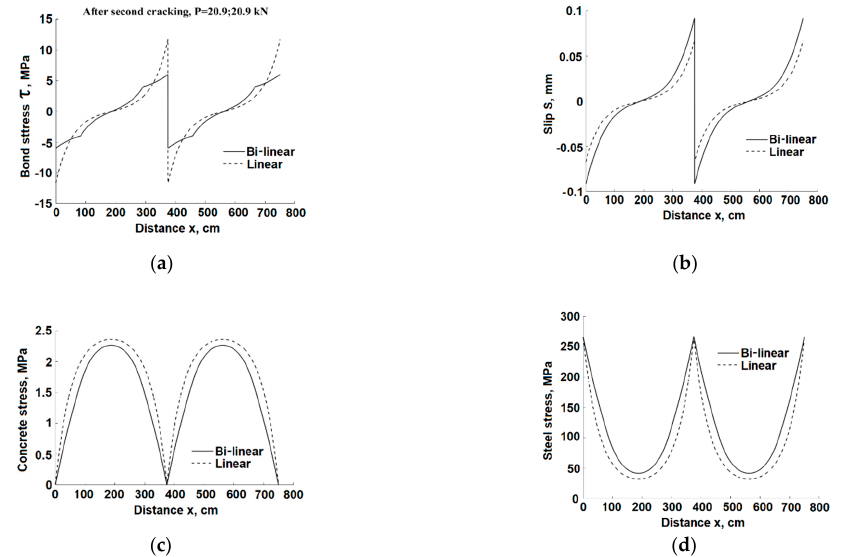
Figure 13. Slip and stresses distributions after second cracking stage ( P = 20.9 kN). ( a ) bond stress; ( b ) slip; ( c ) concrete stress; ( d ) rebar stress.